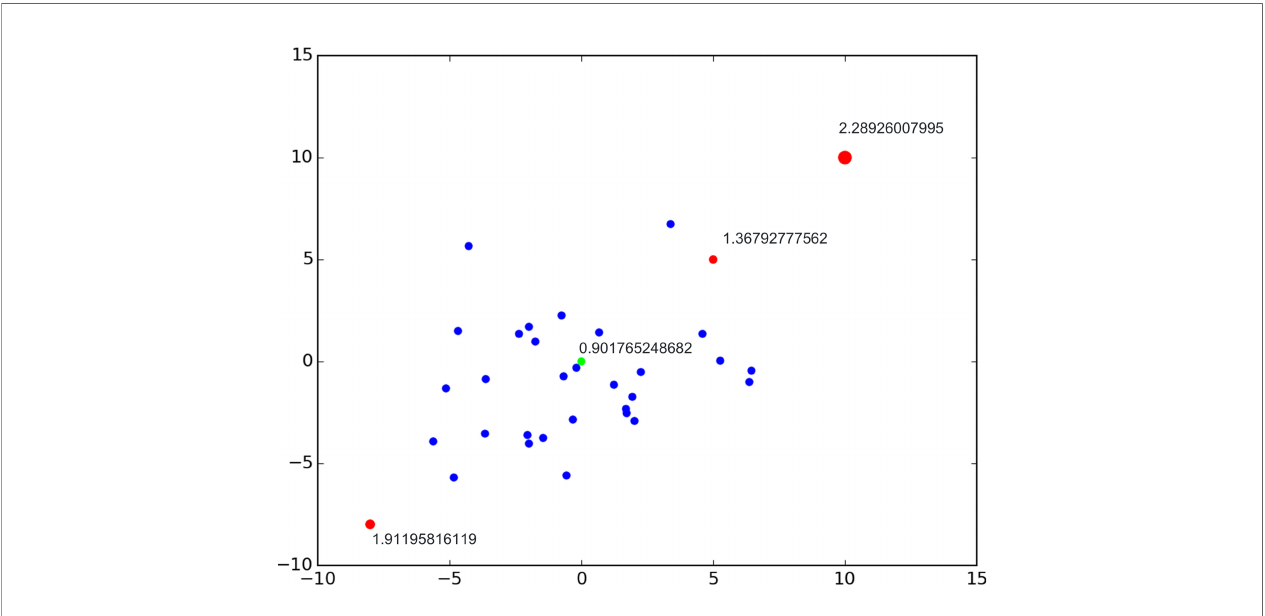
FIGURE 2 | Local outlier factor